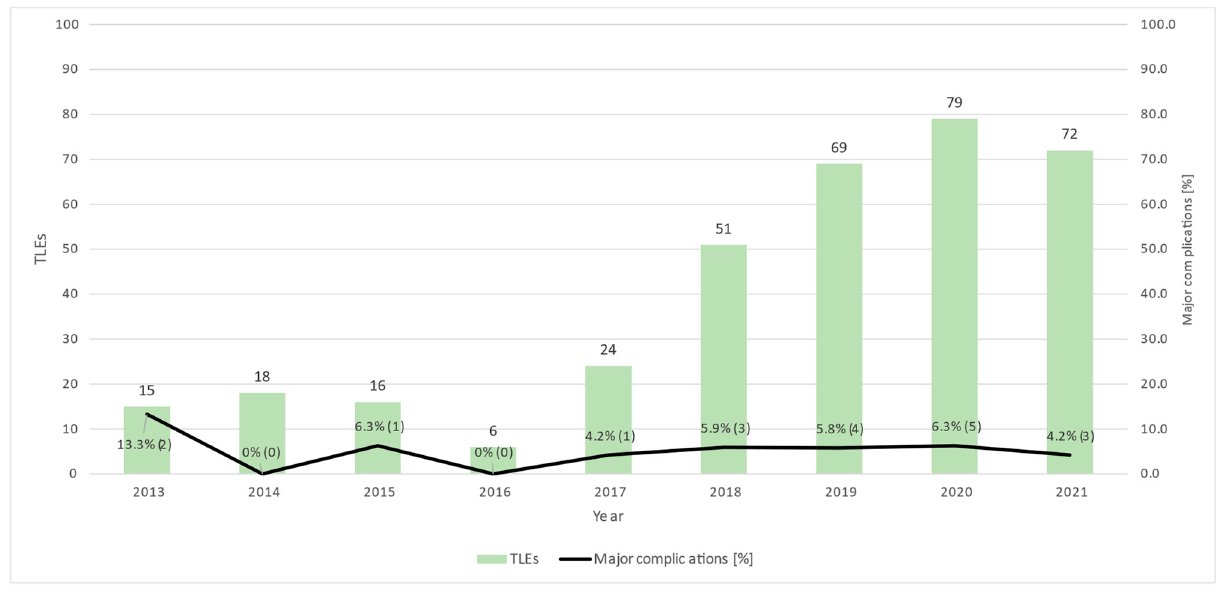
Figure 5. Ratio between TLEs performed and major complications by year. There was an overall increase in TLEs performed from 2013 to 2021. However, the absolute number of major complications was stable, with a subsequent decrease in relative risk. TLE: transvenous lead extraction.